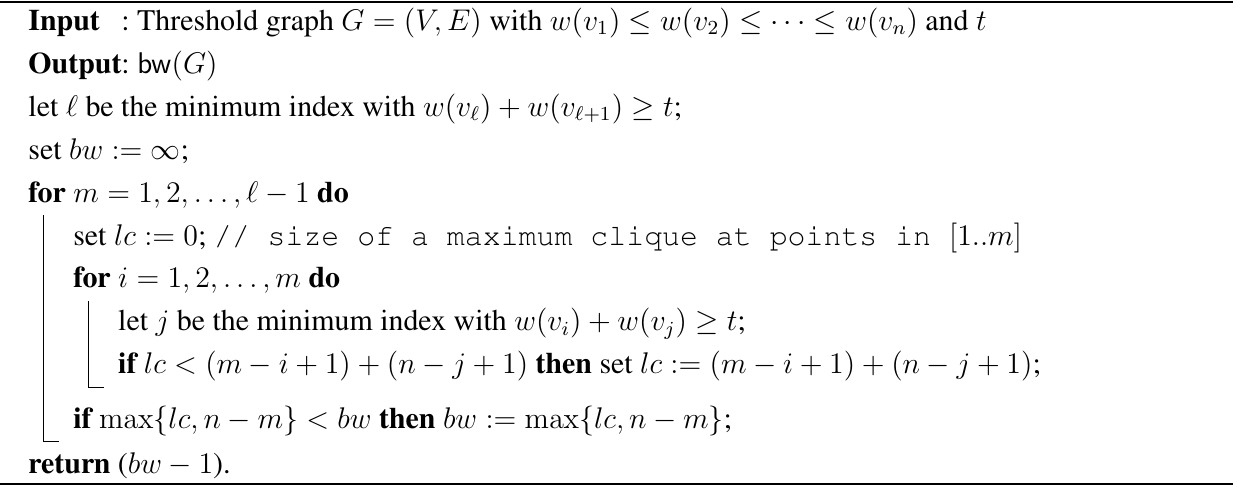
Algorithm 2: Bandwidth of a threshold